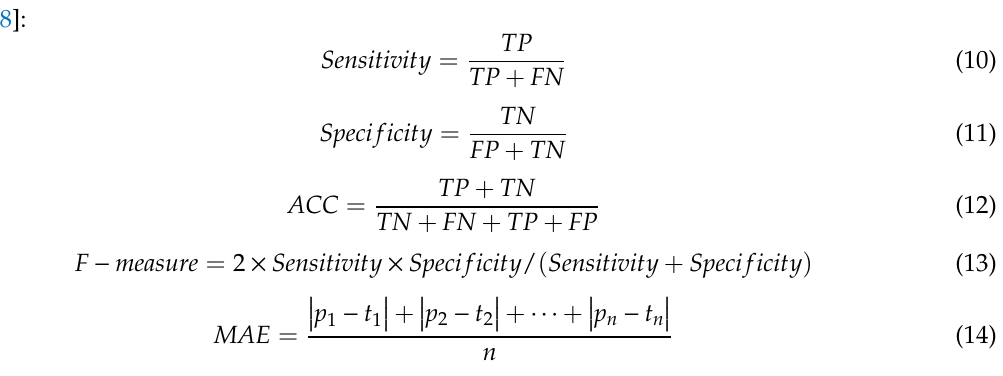
Table 3. The meaning of each indicator in the receiver operative characteristic (ROC) curve. True Positive (Debris Flow) Negative (Non–Debris Flow) Predicted Positive (debris flow) TP (true positive) FP (false positive) Negative (non–debris flow) FN (false negative) TN (true